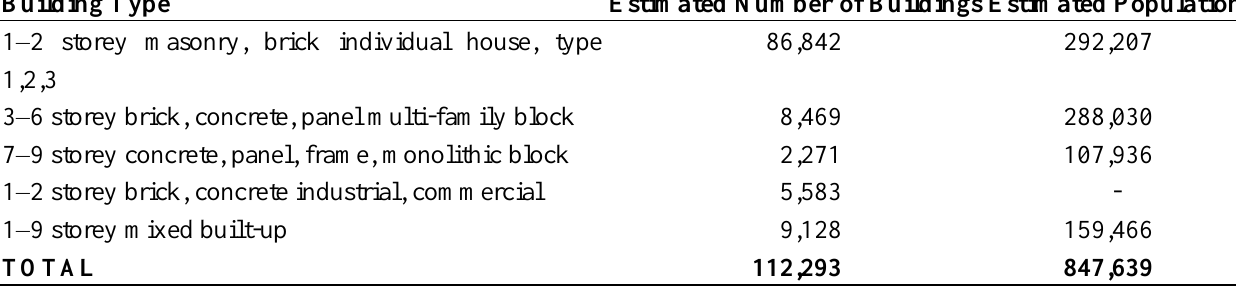
Table 4. Estimated number of buildings and population per building type for the Quickbird subset in 2009 (see Figure 1(b)).